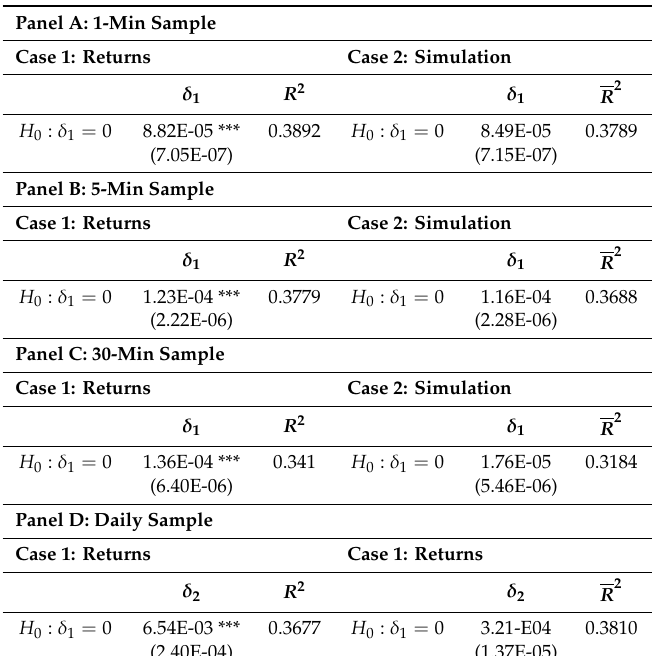
Table 2. Estimation results for the stochastic volatility.